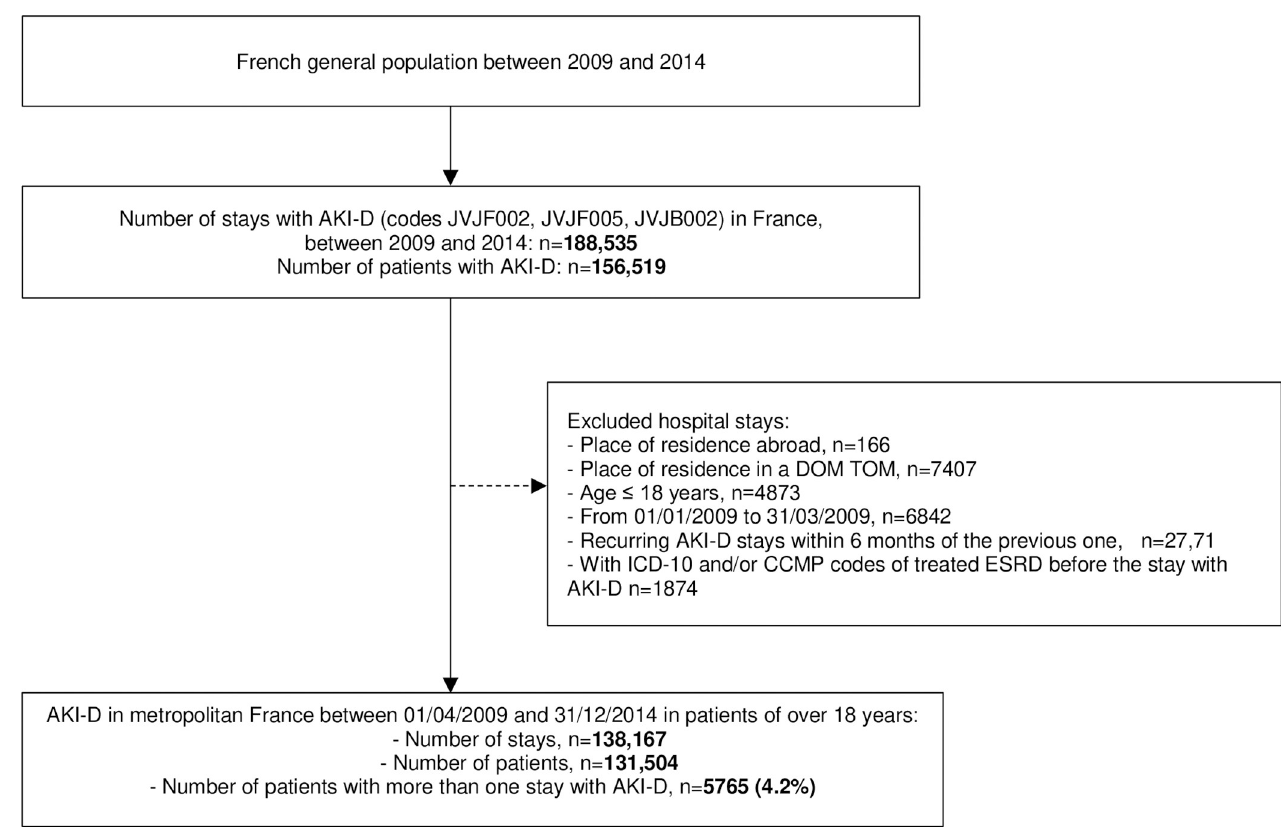
Fig 1. Flow chart. AKI-D, acute kidney injury requiring dialysis; ICD-10, International Classification of disease 10 th version; CCMP, Common Classification of Medical Procedures. DOM TOM, French overseas departments and territories. https://doi.org/10.1371/journal.pone.0211541.g001 PLOS ONE | https://doi.org/10.1371/journal.pone.0211541 February 7,